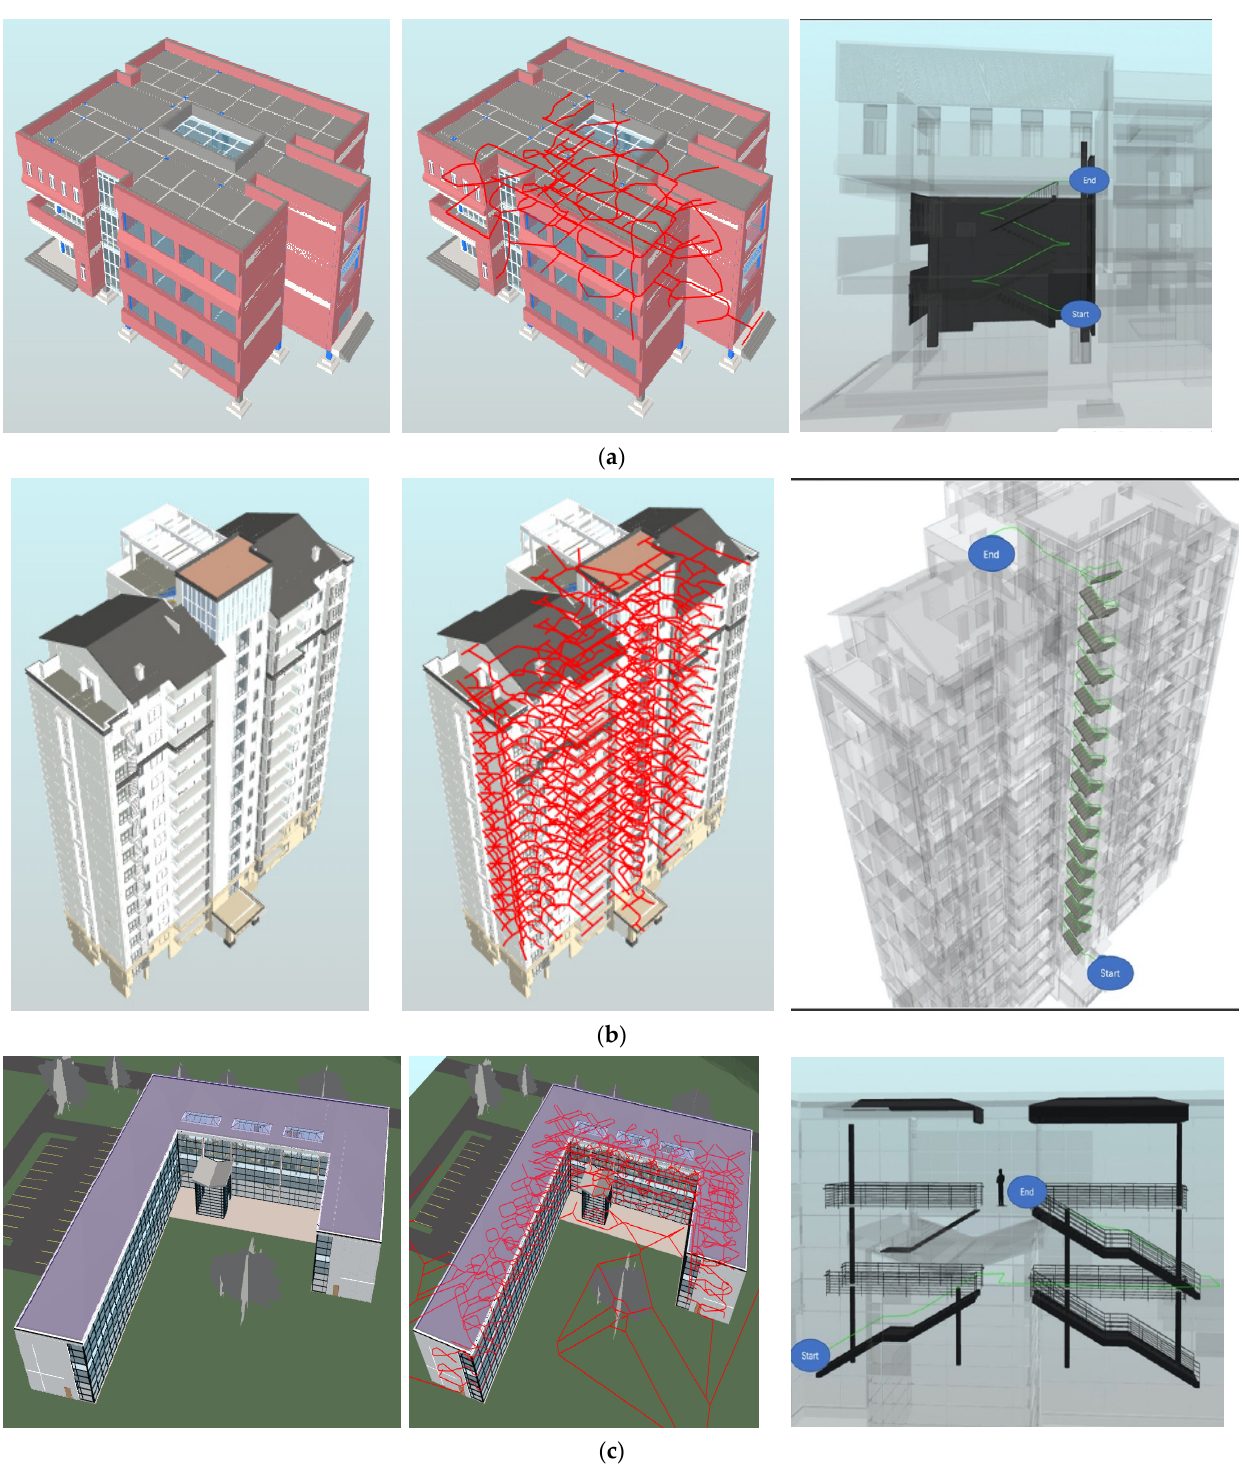
Figure 25. Illustration of the evaluated BIM models and their indoor paths generated by the proposed scheme: ( a ) three-floor teaching building, ( b ) high-rise residential building, and ( c ) comprehensive office building.